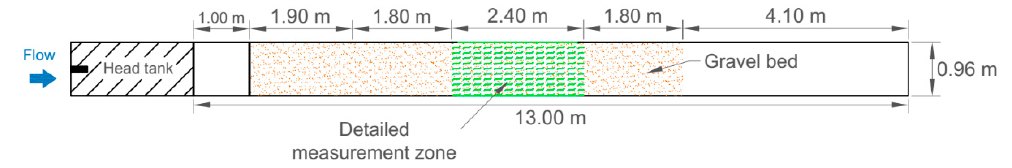
Figure 1. A schematic plan view of the flume. The hatched area shows the detailed measurement zone.